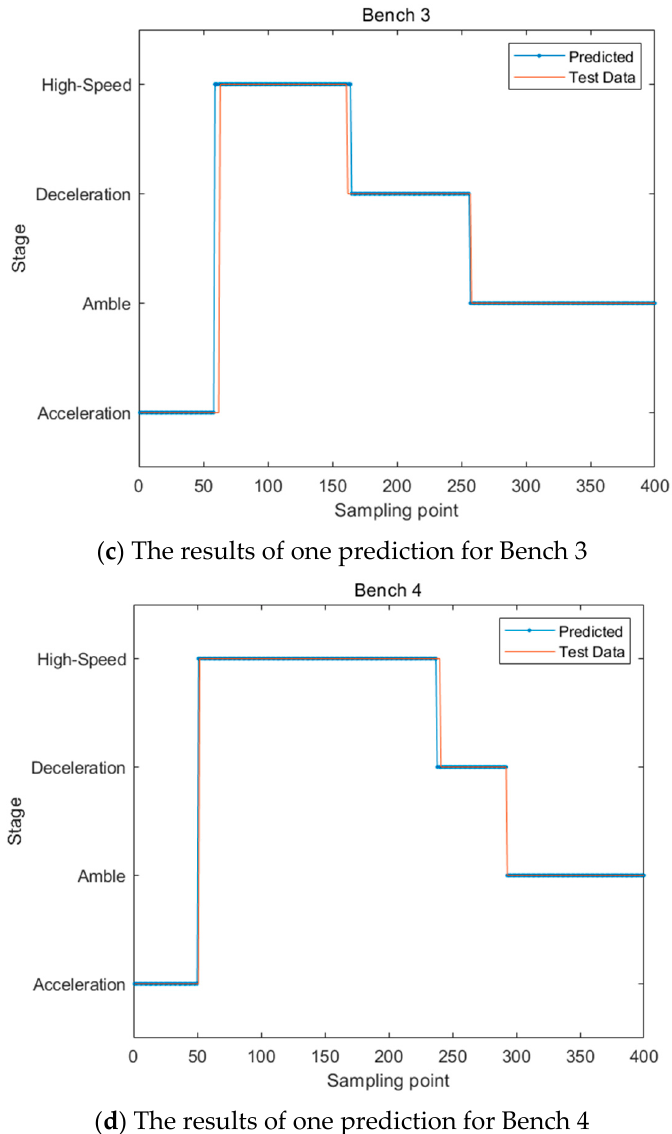
Figure 8. The results of one prediction for different benches.